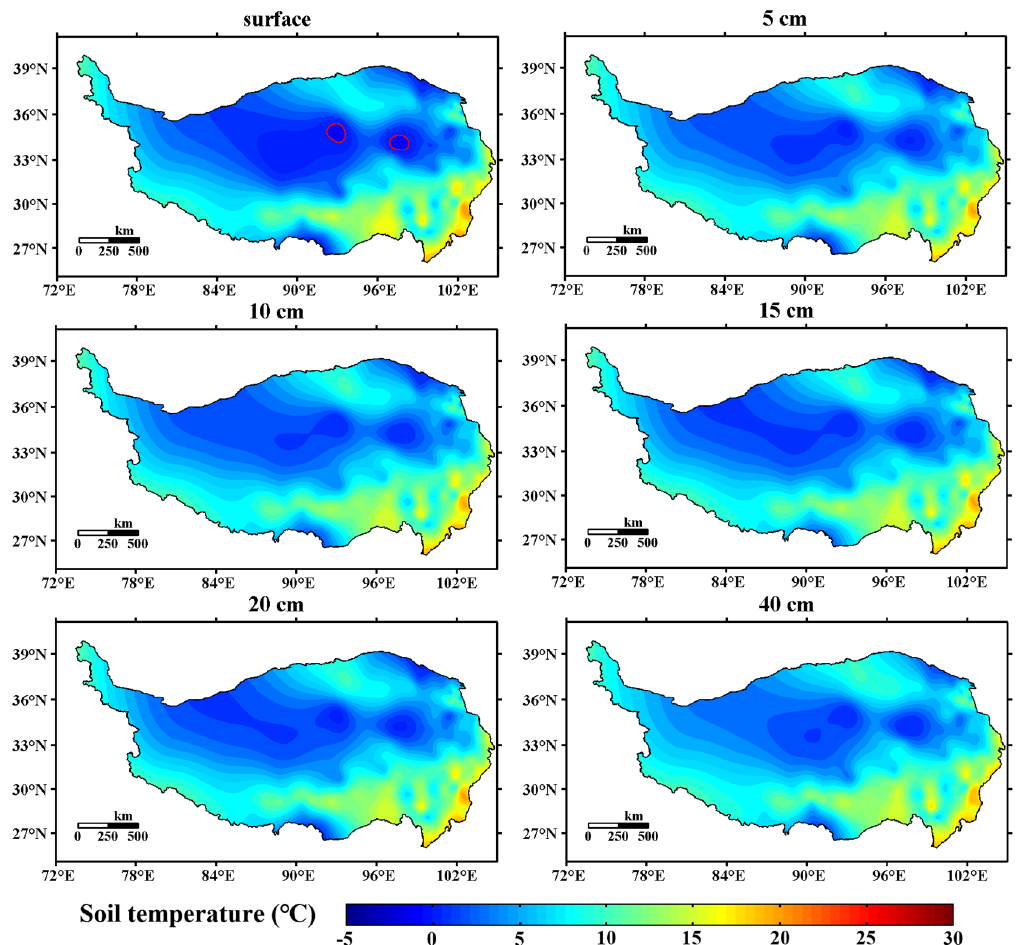
Figure 3. Spatial distribution of annual average ST in the shallow layer of the Qinghai-Tibet Plateau from 1981 to 2020 (unit: °C, Software: MATLAB 2014, https:// ww2. mathw orks. cn/ produ cts/ matlab.